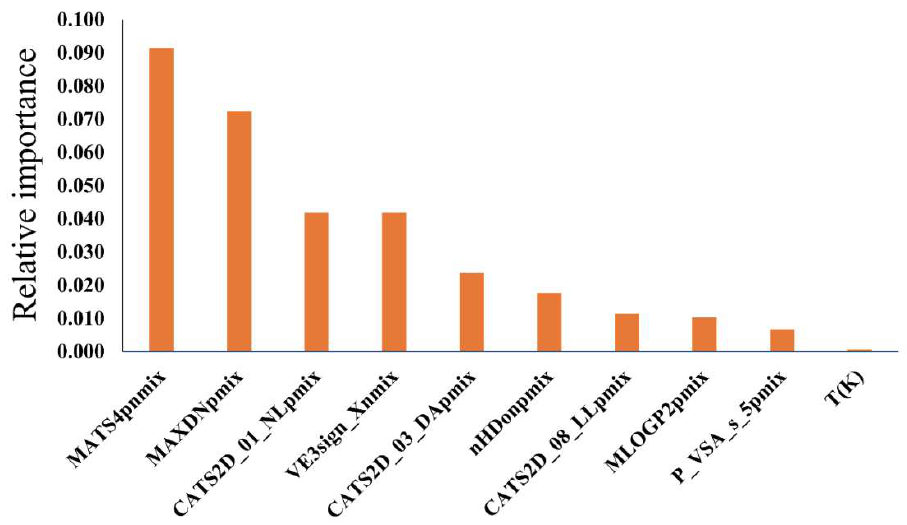
Figure 5. Relative importance of the descriptors found in the best individual model MO59.